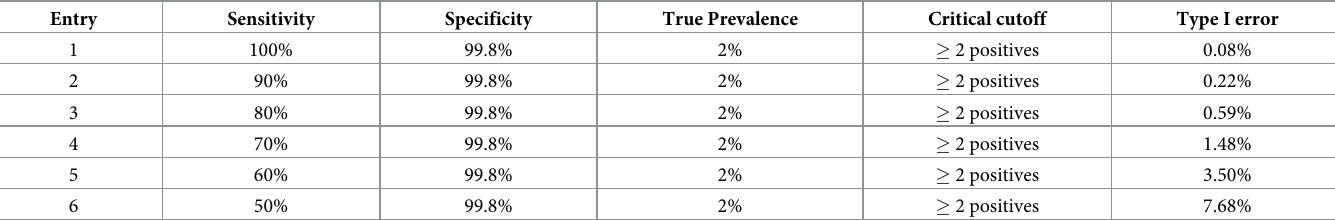
Table 4. Effect of sensitivity on the Type I error of a cluster survey involving 20 villages, and 50 people/participant. A specificity of 99.8% was assumed. The critical cutoff was � 2 positive tests in at least 1 village. The calculations were made for a true prevalence of 2%. At least 60% sensitivity is required to reach a Type I error of < 5%.